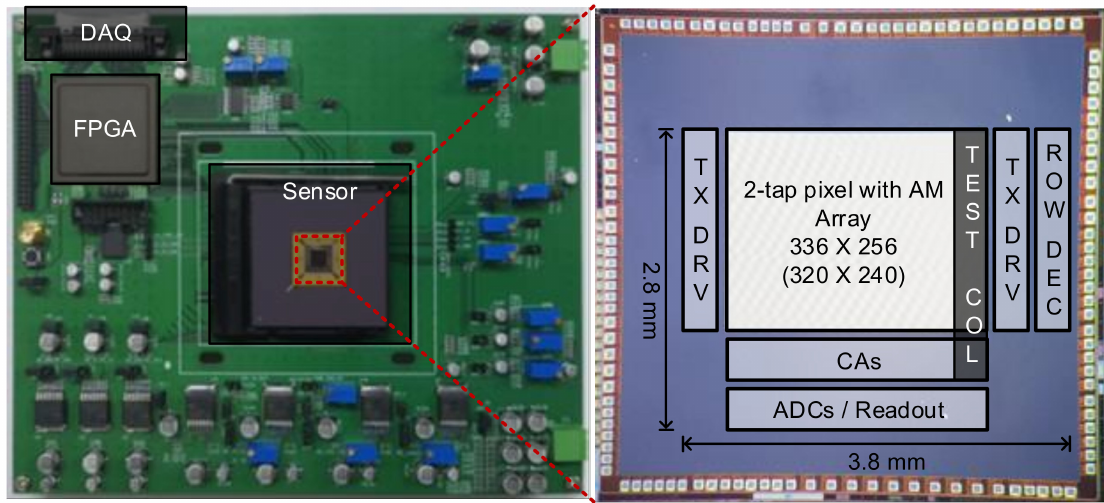
Figure 7. Chip characteristics and chip photograph.